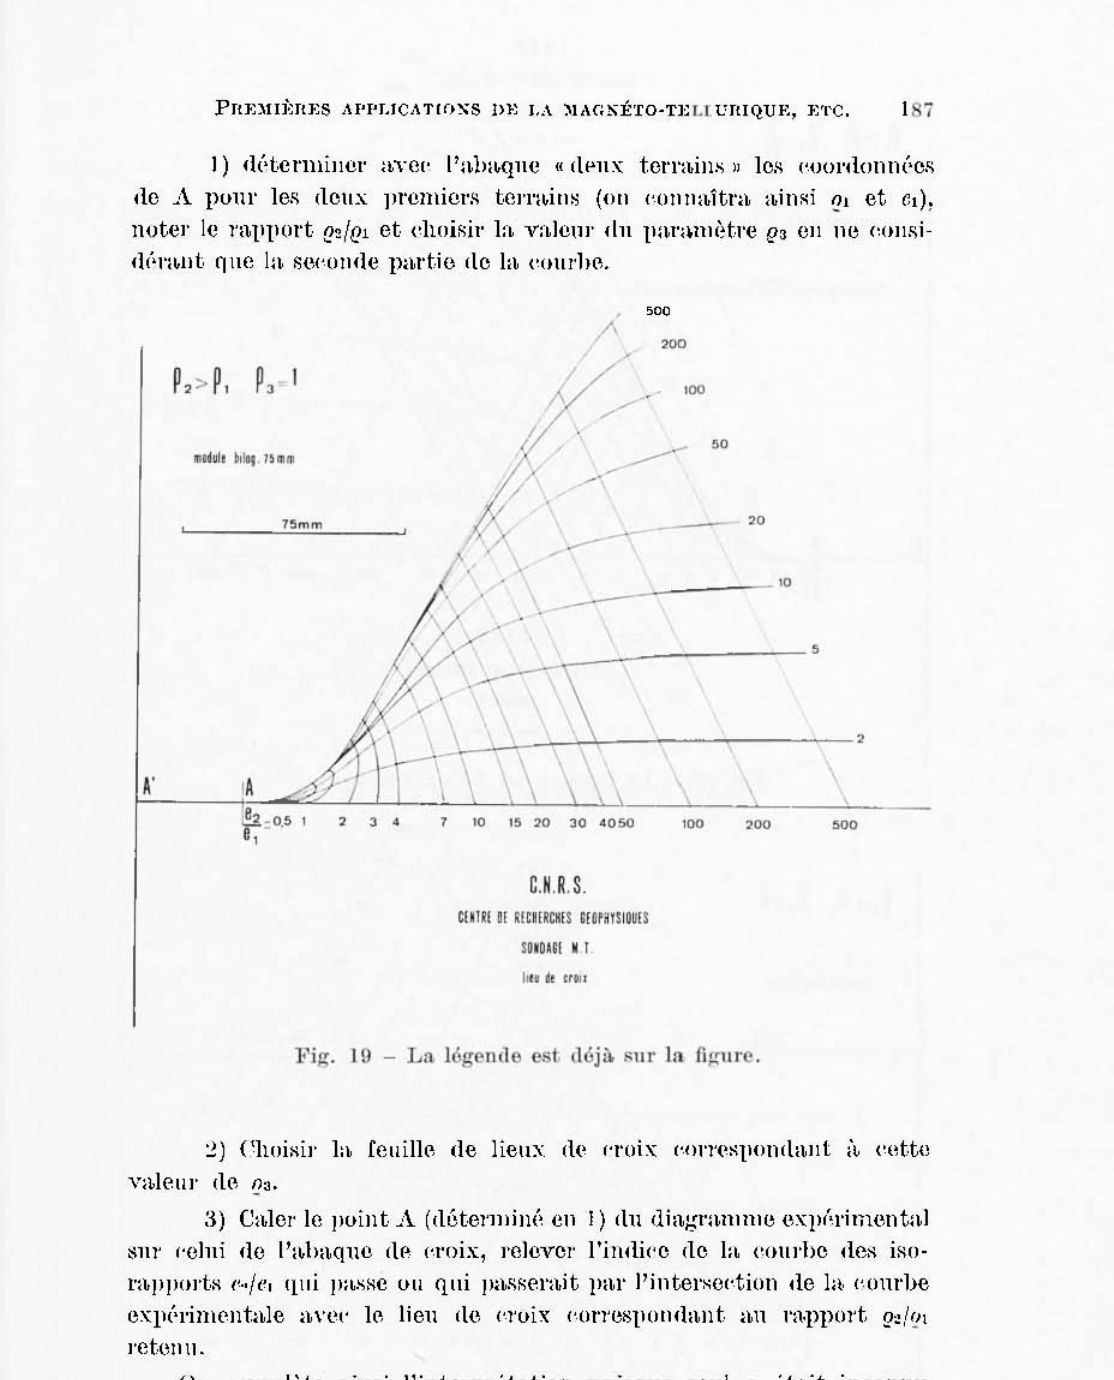
Fig'. lO - La 16gelllie est d6jà. f;ur la